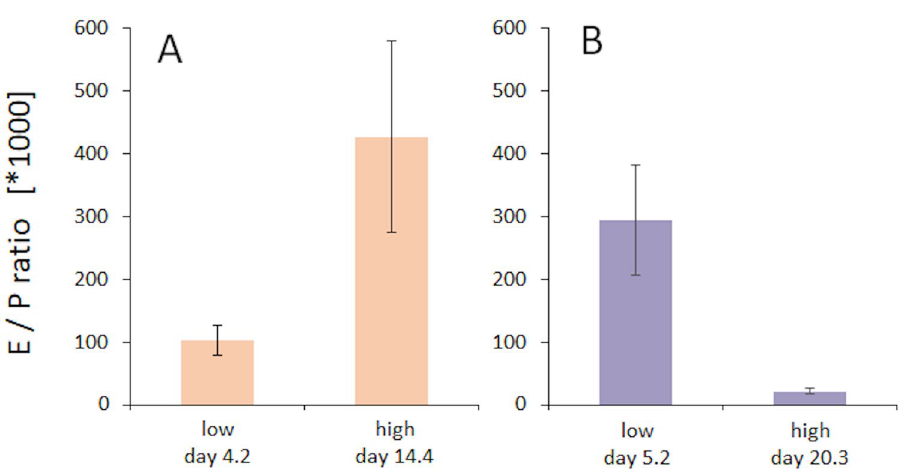
Figure 7. Estradiol to progesterone ratios. Average ratios between estradiol and progesterone (E/P ratio) at times of minimal and maximal estradiol ( A ) and minimal and maximal progesterone ( B ) levels. Data are represented as mean ±